Question: Provide a one-line summary of what is displayed.
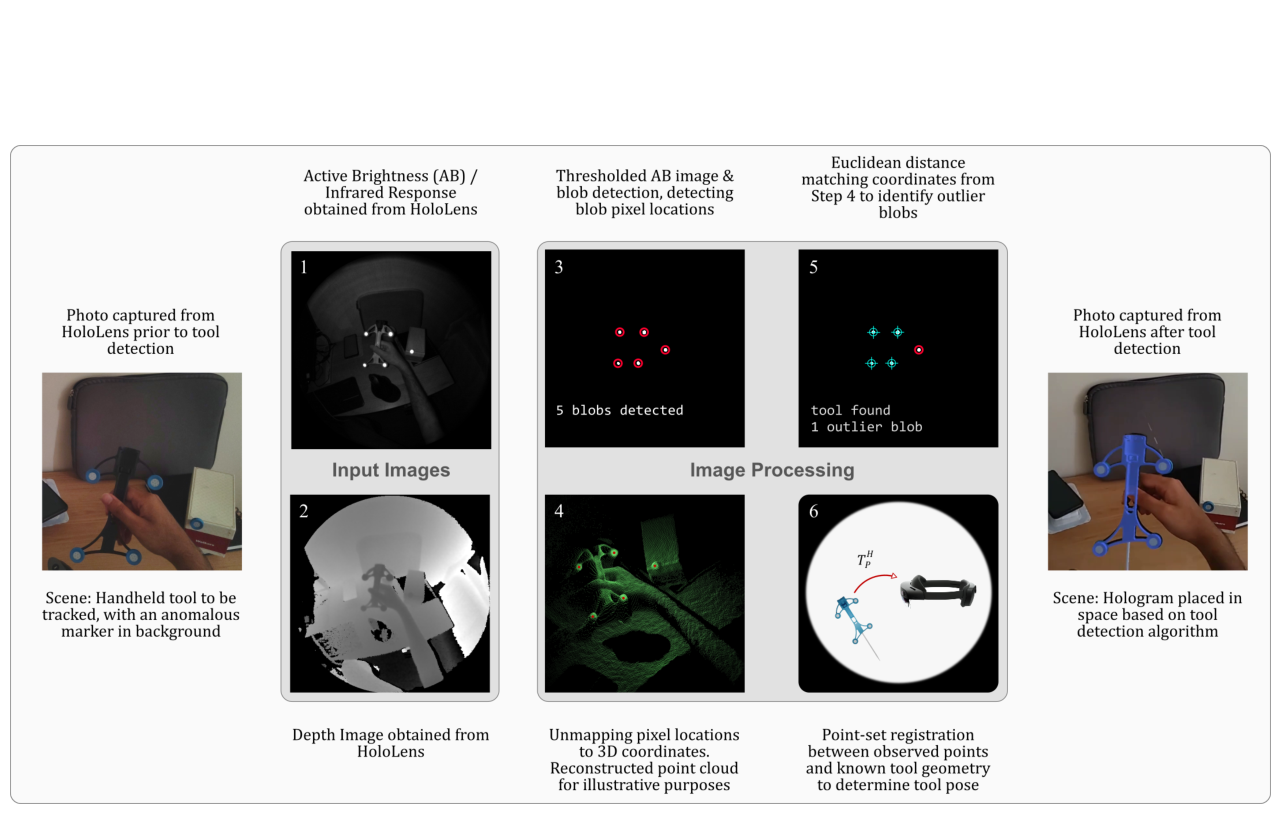
Answer: Pipeline for image processing of sensor images for tool detection and tool pose estimation. Left: Scene prior to tool detection. (1) Input active- brightness (AB) image. (2) Input depth image. (3) Processed AB image following thresholding & blob detection. (4) Reconstructed point cloud from depth image in Figure 2.2, points coloured by IR response. (5) Outlier detection of blobs after unmapping pixel-coordinates to 3D-coordinates and comparing with known tool geometries. (6) Registration process to calculate pose of tool with respect to virtual world frame. Right: Scene after tool detection and AR augmentation.